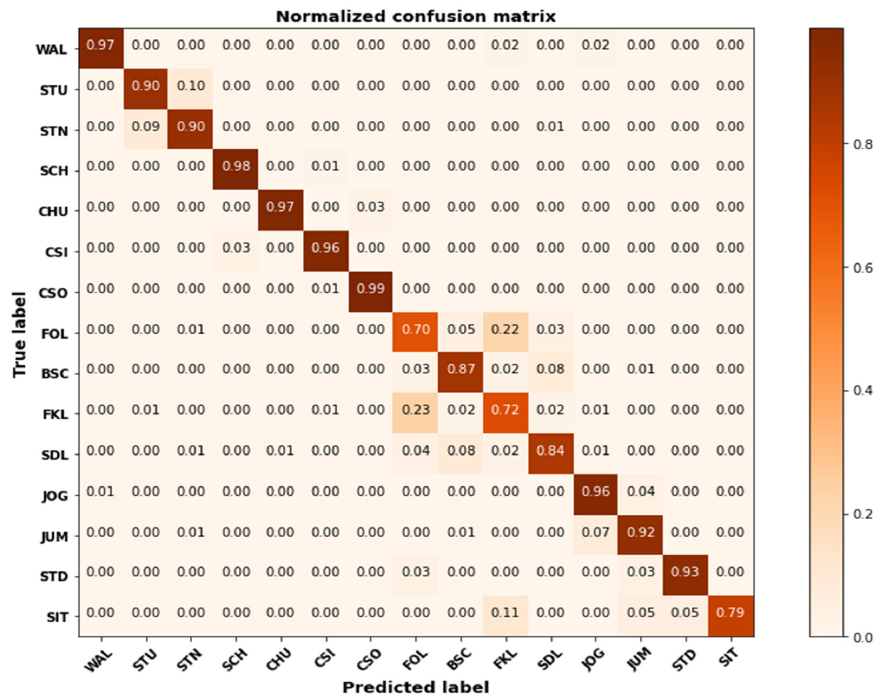
Figure 12. Confusion matrix for MobiAct_v2.0. WAL = walking, STU = stairs-up, STN = stairs-down, SCH = stand-to-sit, CHU = sit-to-stand, CSI = car step-in, CSO = car step-out, FOL = forward lying, BSC = back-sitting chair, FKL = front-knees lying, SDL = sidewards lying, JOG = jogging, JUM = jumping, STD = standing, SIT =